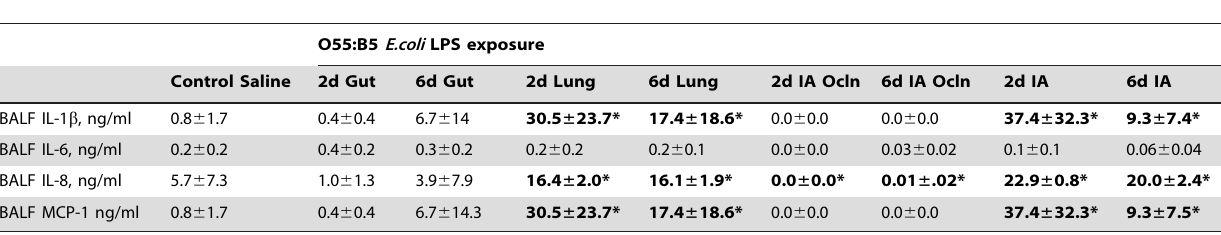
BALF: bronchoalveolar lavage. * p , 0.0125 vs. control.